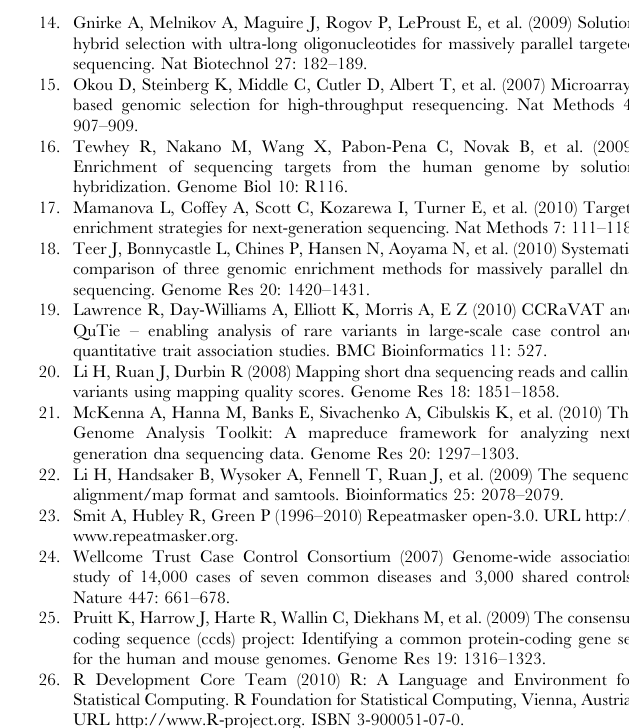
Table S25 Variation detection sensitivity as pool size grows before duplicate removal. This table shows the percentage of the variants called in the pool of 1 individual that are also called as variants in the larger pool sizes. The individual in the pool of 1 was also in each subsequent larger pool, therefore all variants called in the pool of 1 should also be found in all subsequent pools. Table S26 Percent of called HapMap variants with correctly, under, and over estimated non-reference allele frequencies after duplicate removal. For the pools of 10, 20 and 50 individuals and each enrichment method this table details the percent of true positive variants that the non- reference allele frequency was correctly, under, or over estimated by the sequencing based variant caller relative to the reference genotypes. Table S27 Percent of called HapMap variants with correctly, under, and over estimated non-reference allele frequencies before duplicate removal. For the pools of 10, 20 and 50 individuals and each enrichment method this table details the percent of true positive variants that the non- reference allele frequency was correctly, under, or over estimated by the sequencing based variant caller relative to the reference genotypes. Table S28 Pool of 20 technical replicates dbSNP overlap and HapMap/1KG sensitivity after duplicate removal.